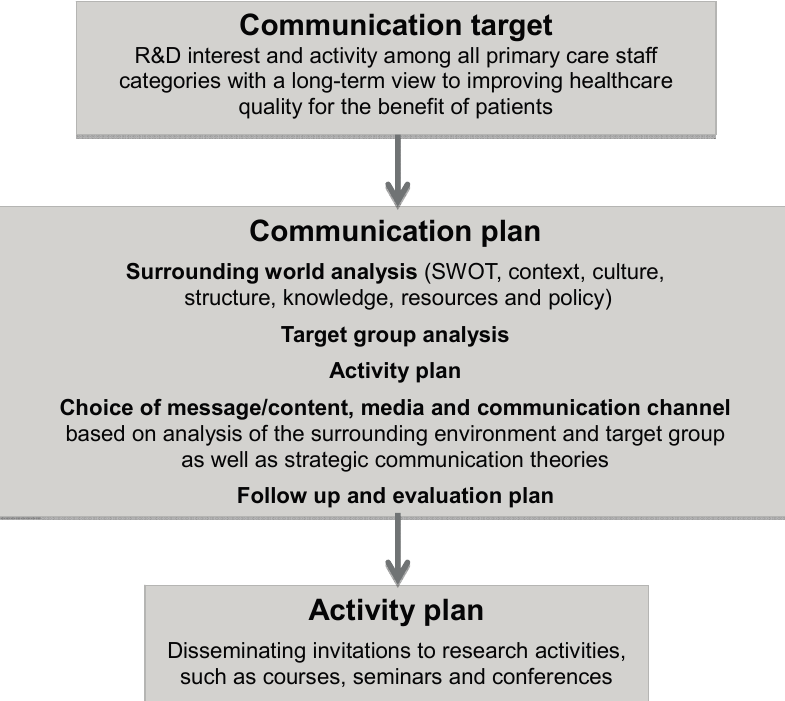
Figure 1. Intervention flow chart of measurement outcomes in relation to the goal of the communication strategy in the study